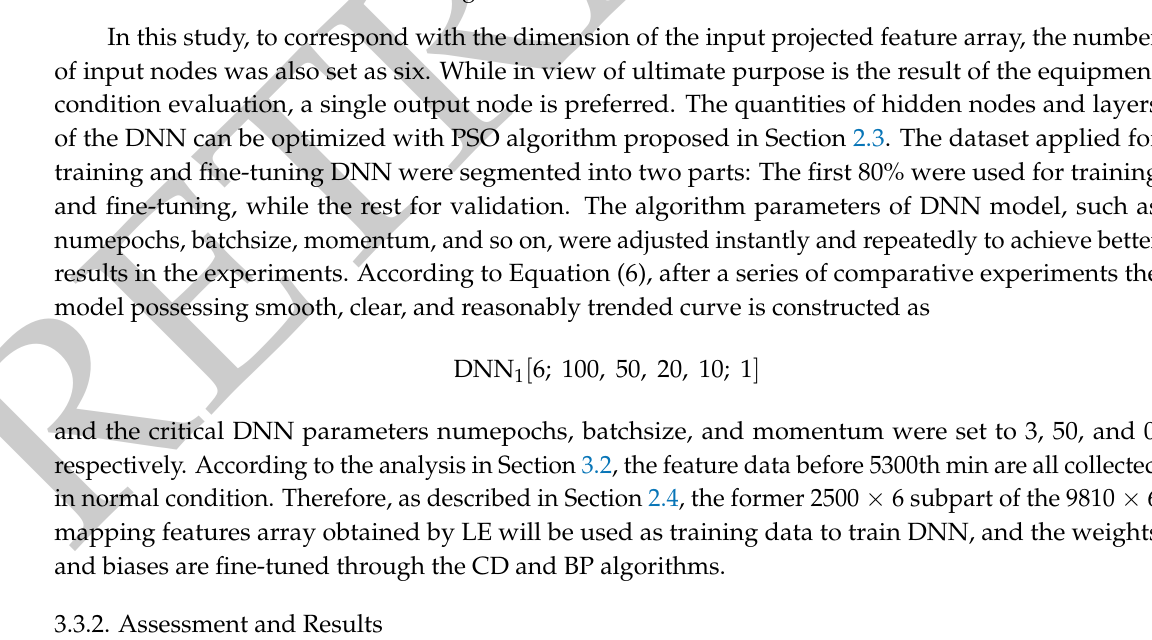
Figure 6. The six features in projected feature space.